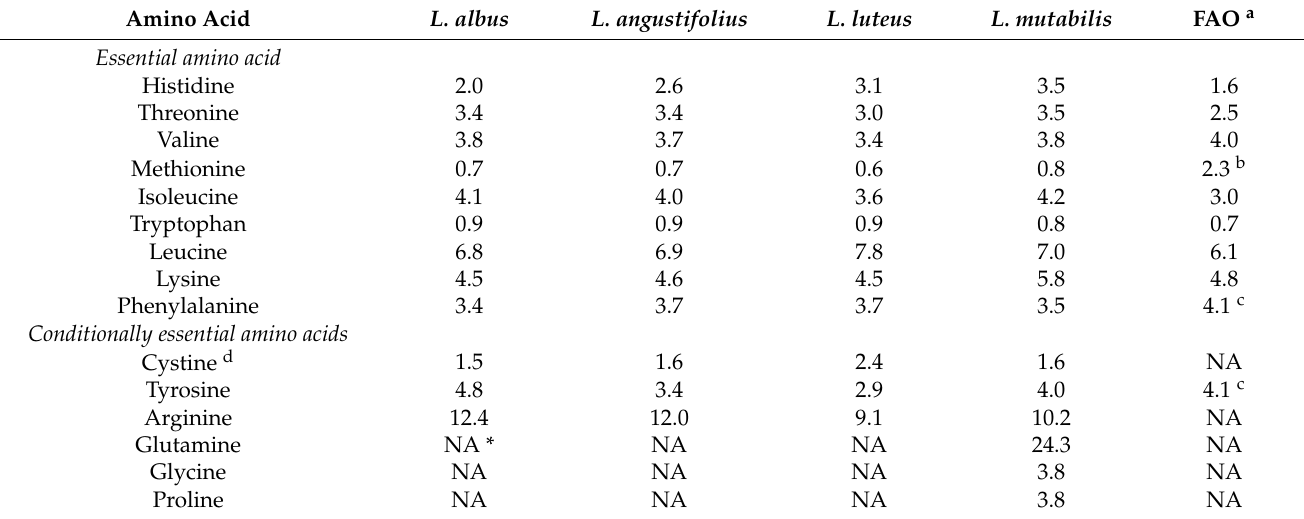
Table 1. Essential amino acid content of different lupin species (g/100